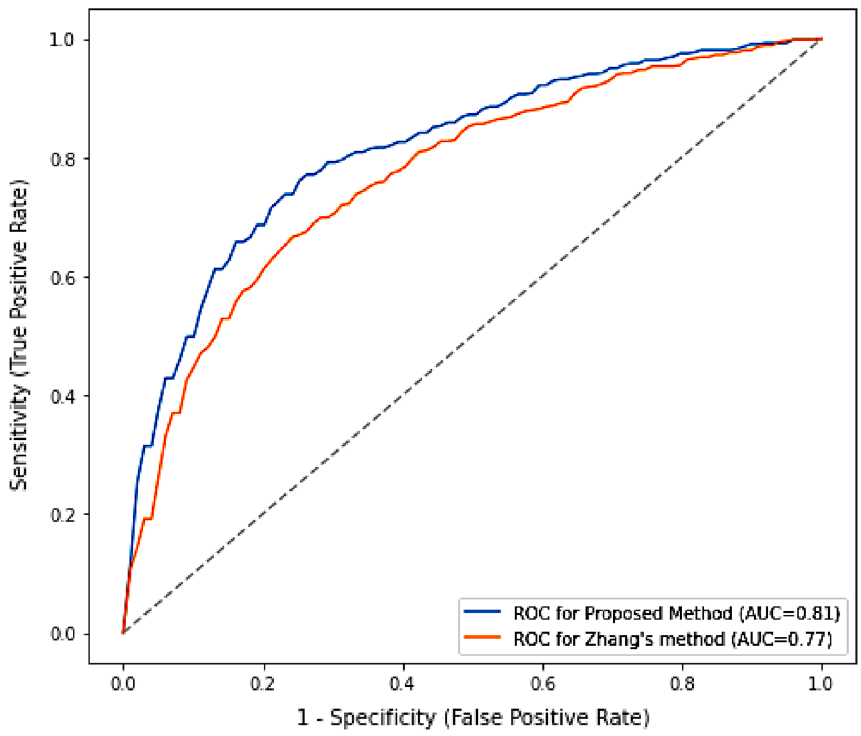
Figure 3. Comparison of the roc curves with the